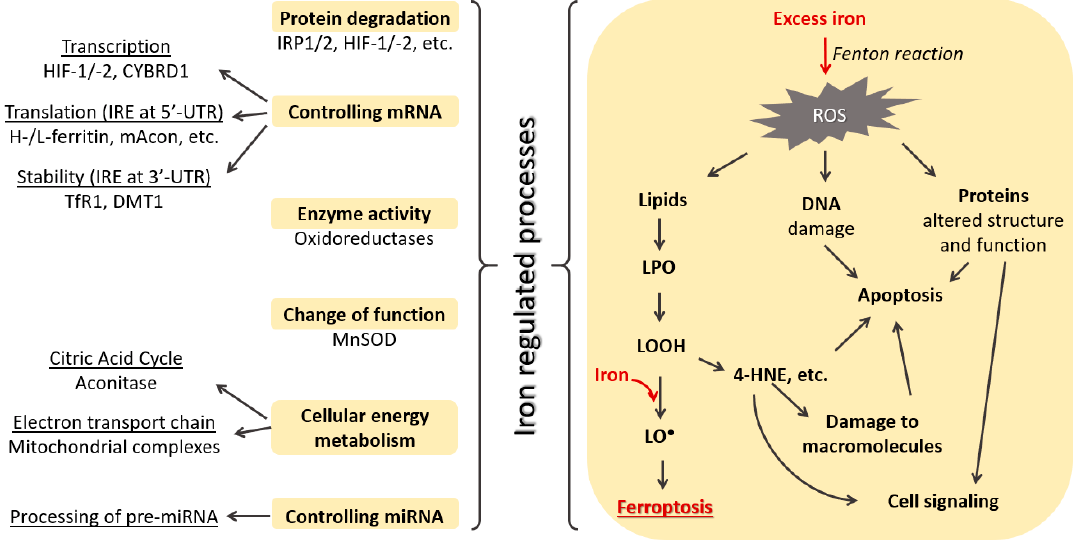
Figure 1. Some cellular processes regulated by iron.